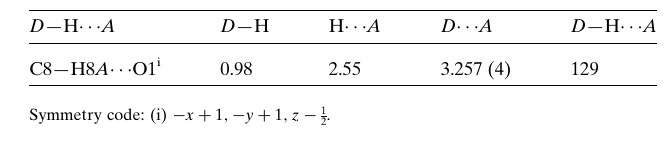
Table 1 Hydrogen-bond geometry (A˚ , (cid:3) ) for (I).